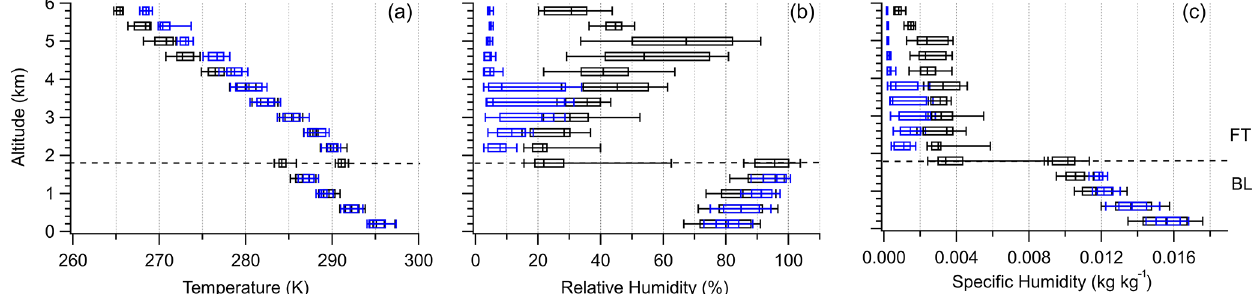
Figure 9. The vertical distributions of temperature (a) , RH (b) and specific humidity (c) under clean (blue) and BB-polluted (black) condi- tions. Data for BB-polluted conditions are composited from periods 2 and 3 in the FT and periods 1 and 3 in the BL. Data for clean conditions are composited from period 1 in the FT and period 2 in the BL. The box-and-whisker plots represent the 10th percentile, 25th percentile, median, 75th percentile and 90th percentile in every 400m bin.